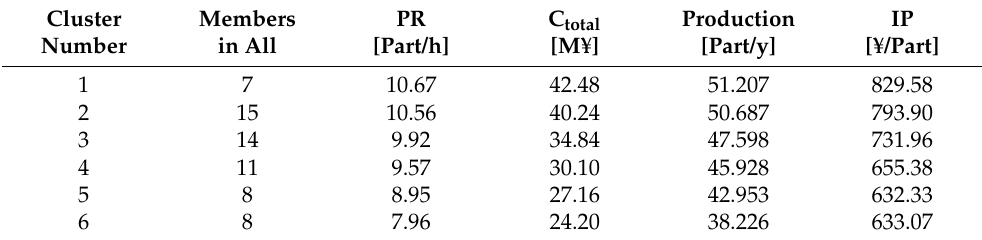
Table 5. Cluster analysis of the original approach [4] (Case